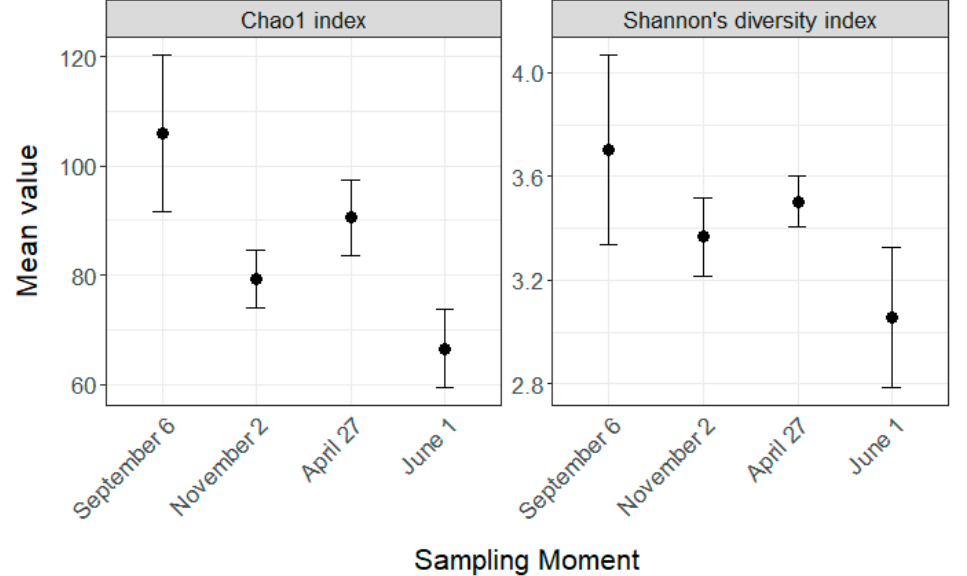
Figure 3. Alpha diversity of the gut microbiota regarding the four key sampling moments. Diversity was measured with Chao1 and Shannon’s diversity index. The overwintering period was from November 22 to April 20. Error bars indicate 95% confidence intervals.